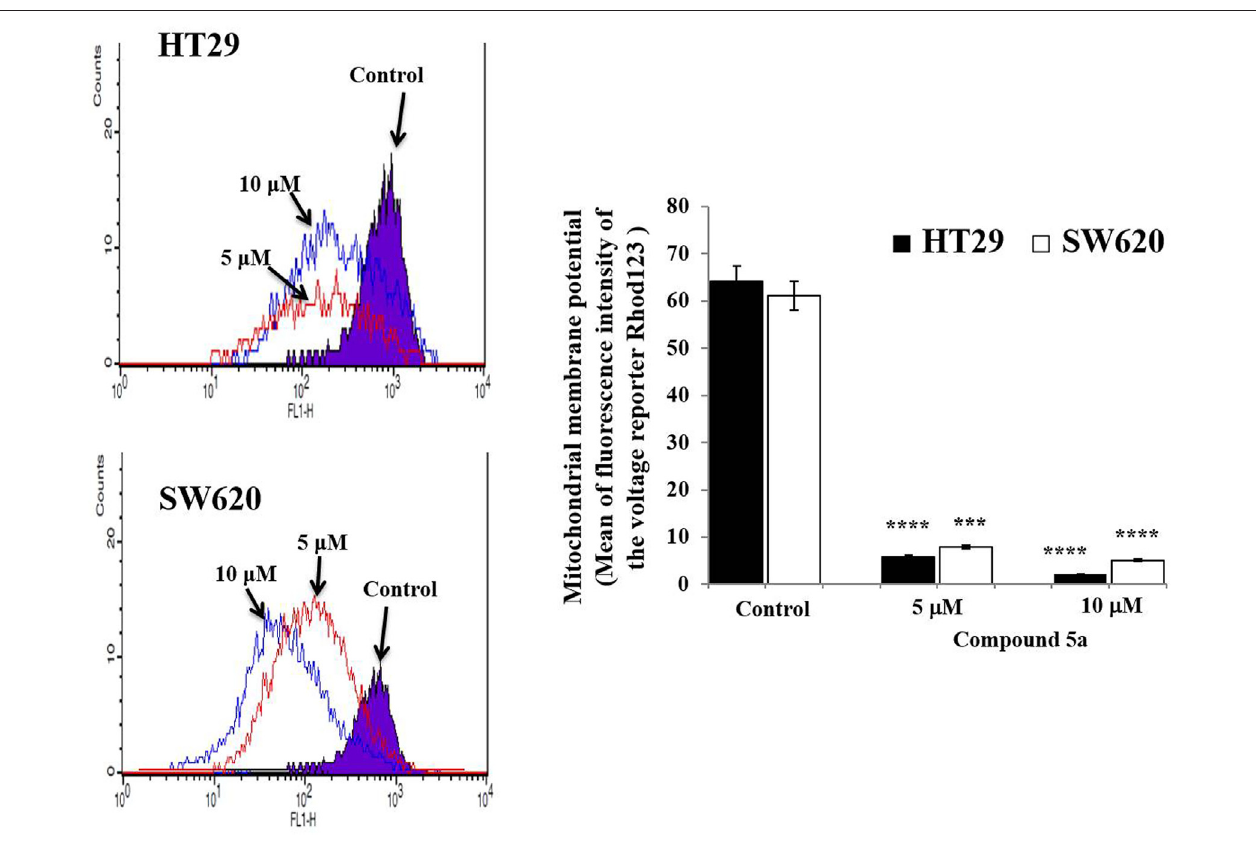
FIGURE 6 | Compound 5a decreases the mitochondrial membrane potential in HT29 and SW620 cells. Representative histograms reveal the mitochondrial membranepotentialmonitored inuntreatedandCompound5a-treated HT-29andSW620cellsafter voltagereporterrhodamine123stainingandusing fl owcytometry. The bar graph depicts the mean mitochondrial membrane potential, and the data are presented as mean ± SD ( n = 3). *** p < 0.001 and **** p < 0.0001 vs . Control.